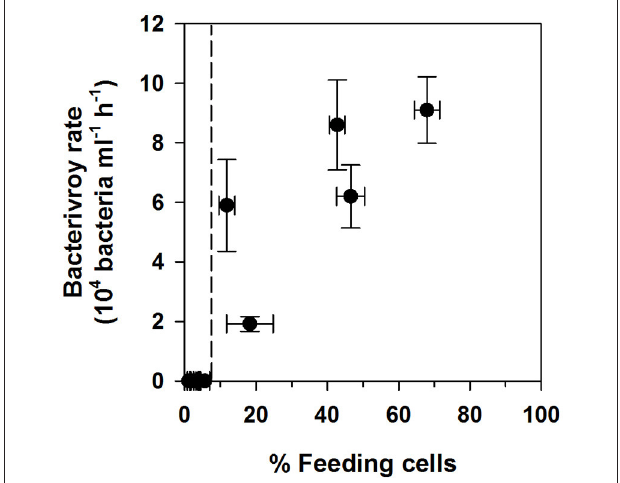
FIGURE 4 | Comparison of measured bacterivory rates and percentages of feeding cells. Data has been pooled for all three algal strains. The dashed line indicates the observed threshold for bacterivory rate detection.